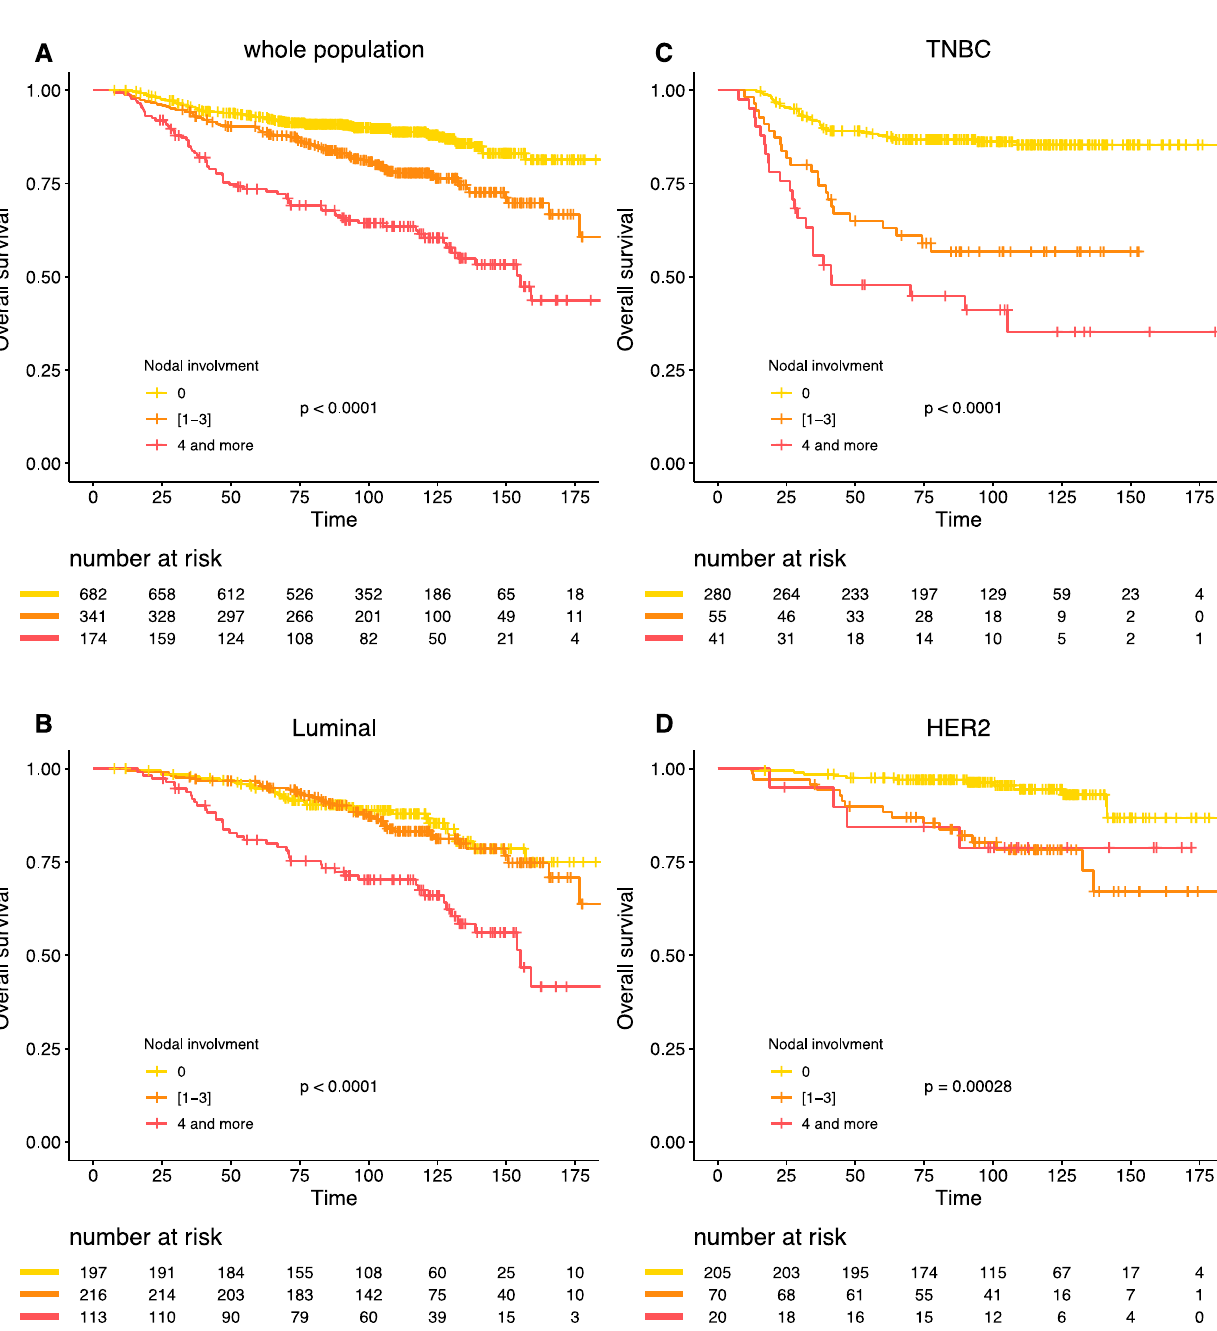
Figure 3. Overall survival according to post NAC nodal involvement in the whole population ( A ), Luminal BC ( B ), TNBC ( C ), and HER-2 positive BC ( D ).